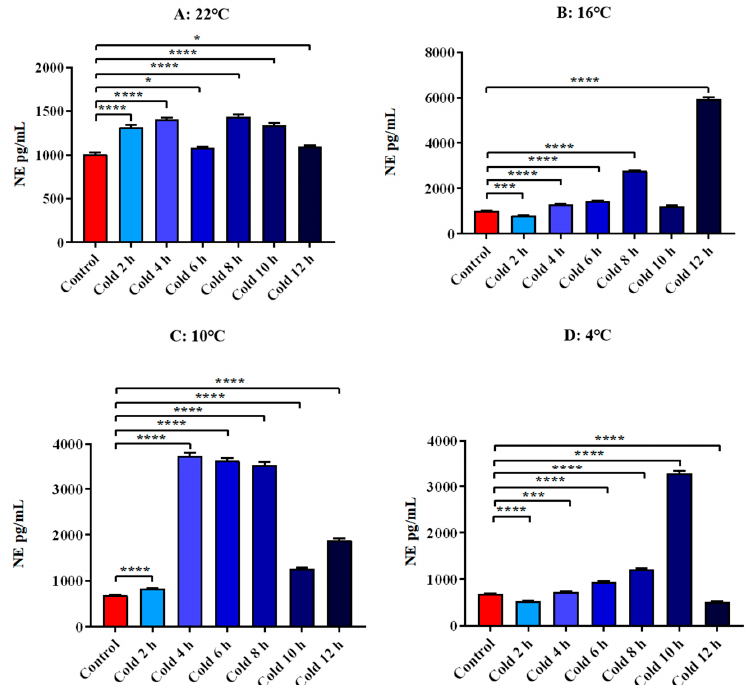
Figure 11. Changes in serum NE of ICR mice under different intensity of cold exposure. ( A ). Changes in the serum NE of mice under cold exposure at 22 ◦ C; ( B ). Changes in serum NE of mice under cold exposure at 16 ◦ C; ( C ). Changes in the serum NE of mice under cold exposure at 10 ◦ C; ( D ). Change in the serum NE of mice under cold exposure at 4 ◦ C. Compared with 28 ◦ C normal temperature control group, the difference was significant as * p < 0.05. *** p < 0.001. **** p < 0.0001. 3.4.3. Changes in Serum 5-HT and DA of ICR Mice in Elevated Plus Maze Test under Different Intensity of Cold Exposure There was no significant difference in the level of 5-HT at each time point at 22 ℃ . The levels of 5-HT were significantly increased at 16 ℃ for 2 h and 4 h ( p < 0.05). After cold exposure at 10 ℃ , it was significantly increased for 4 h, 6 h and 8 h. After cold expo- sure at 4 ℃ , it was significantly increased for 2 h, 6 h and 12 h. ( p < 0.05). All these results are shown in Figure 12.